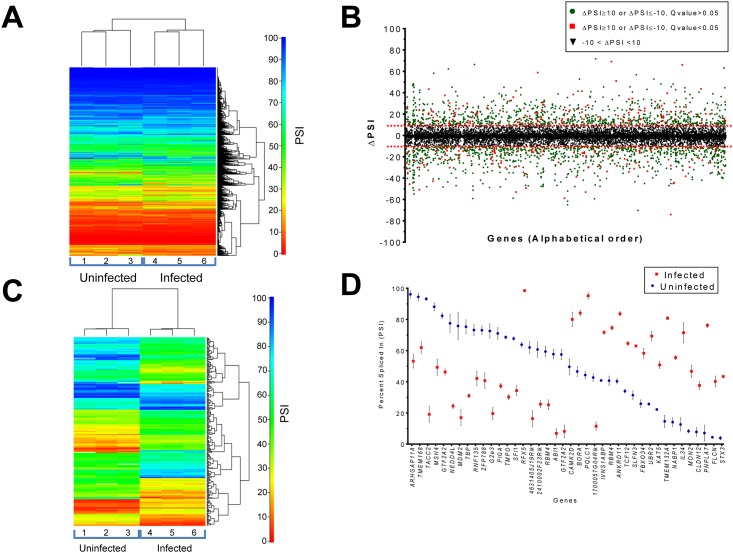
Global profiling of the cellular alternative splicing landscape and identification of differentially spliced ASEs during virus-host interactions.(A) Heatmap representation of isoform ratios for cellular transcripts in both infected and uninfected (mock) cells. RNA sequencing was done in triplicate for each condition. The map represents the percent-spliced-in (PSI) values based on isoform expression for the long and the short ASEs (see Materials and methods). Blue indicates high PSI values and red indicates low PSI values. (B) Alternative splicing events (ASEs) in cells infected with reovirus. ASEs were detected and quantified using the percent-spliced-in (PSI) metric. The graph shows an analysis of the difference in PSI values (Delta PSI) of the cellular genes following viral infection. Black triangles indicate Delta PSI values between -10 and 10, red squares indicate Delta PSI values greater than 10 or less than -10 with a Q value under 0.05, and green circles indicate same Delta PSI values but with a Q value above 0.05. (C) Heatmap representation of the 240 ASEs that are differentially spliced upon viral infection. RNA sequencing was done in triplicate for both the uninfected (mock) and infected cells. Blue indicates high absolute PSI values and red indicates low absolute PSI values. (D) PSI distribution of the 40 primary ASEs for which AS is the most significantly altered upon viral infection. The PSI values for the respective ASEs are indicated both for the uninfected and infected cells. Error bars indicate standard deviation.